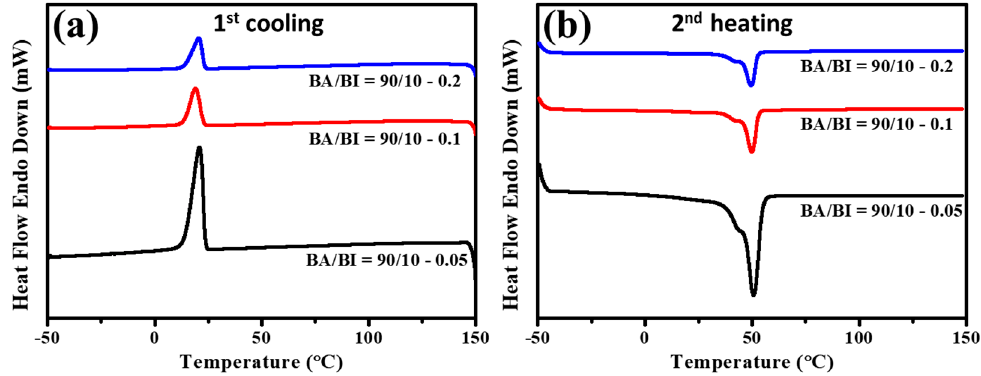
Figure 12. DSC trace of PBABI copolyesters with different concentrations of BTCA: ( a ) curves of cooling in the first cycle and ( b ) curves of reheating in the second cycle.